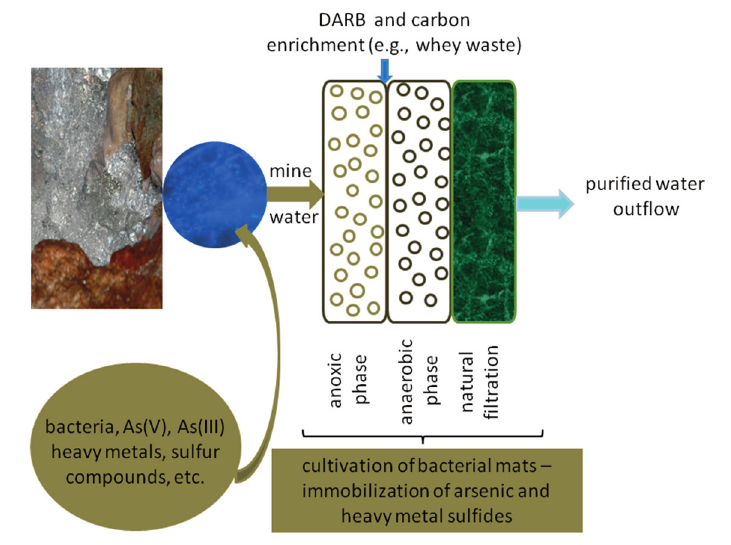
Figure 9. Microbial mats’ culturing system for arsenic removal from